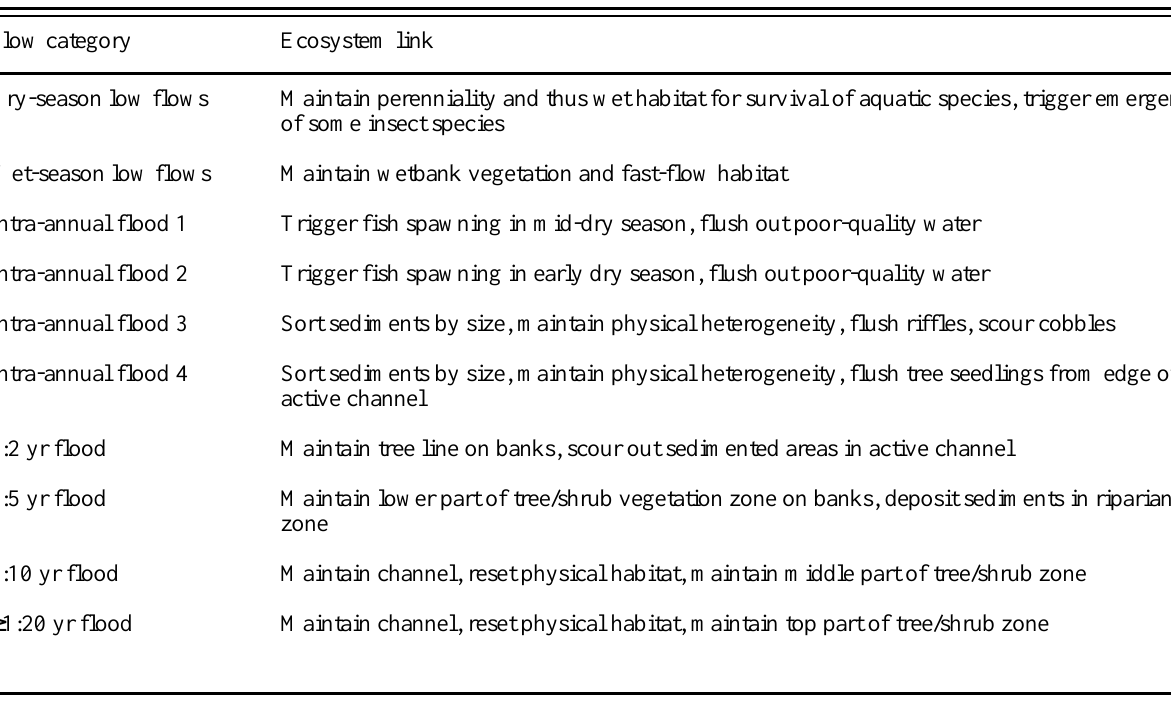
Table 3 . Some possible links between flow categories and ecosystem functioning in Western Cape rivers, South